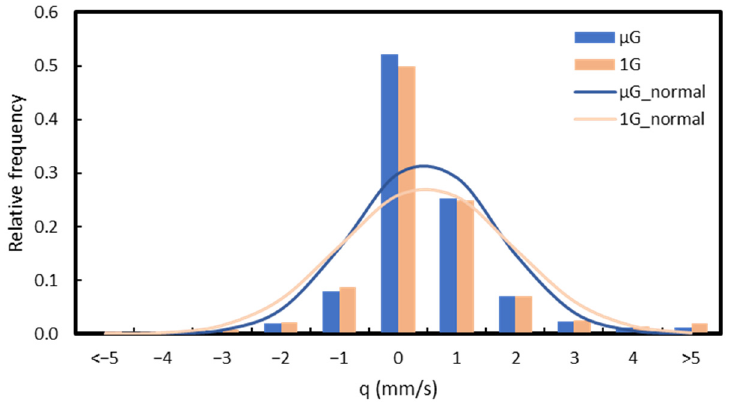
Figure 5. Water flux densities at every 0.001 s in porous media under ( a ) microgravity and ( b ) 1 G.